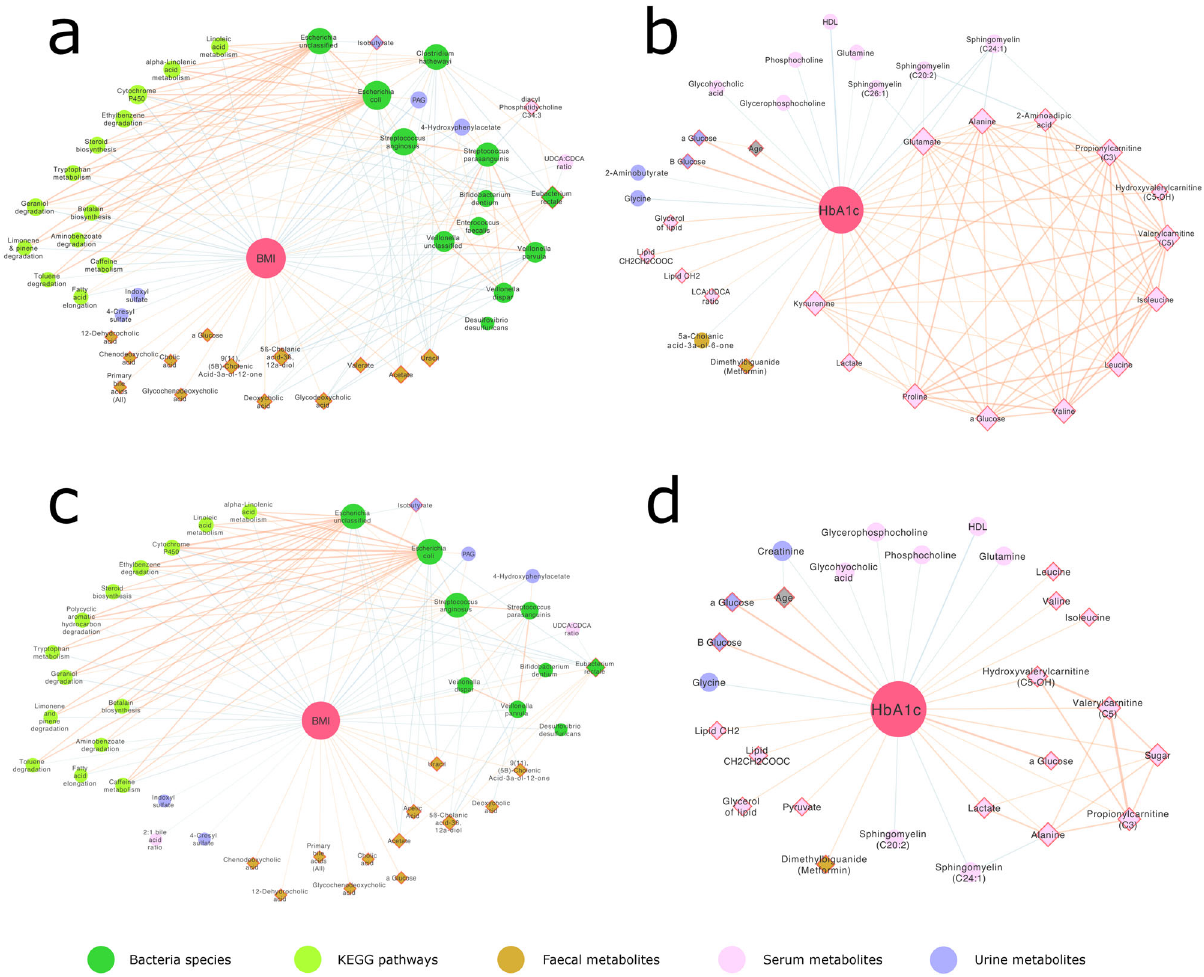
Fig. 7 Metabolite and gut microbiota correlations with BMI and HbA1c. First-order Spearman correlations to ( a ) body mass index (BMI) and ( b ) glycated haemoglobin (HbA1c) derived from metabolite and microbiota datasets. c Partial Spearman correlations to BMI, correcting for HbA1c. d Partial Spearman correlations to HbA1c, correcting for BMI and weight (weight independent HbA1c correlations) ( n = 108). Correlations with a corrected pFDR < 0.01 are shown. Variables with a negative correlation to BMI / HbA1c are displayed within a circle, variables with a positive correlation have a diamond shape and red outline. Node size is proportional to the number of signi fi cant correlations to that variable. Positive correlations between variables are shown with orange lines, negative correlations have blue lines. Line thickness is proportional to the correlation strength